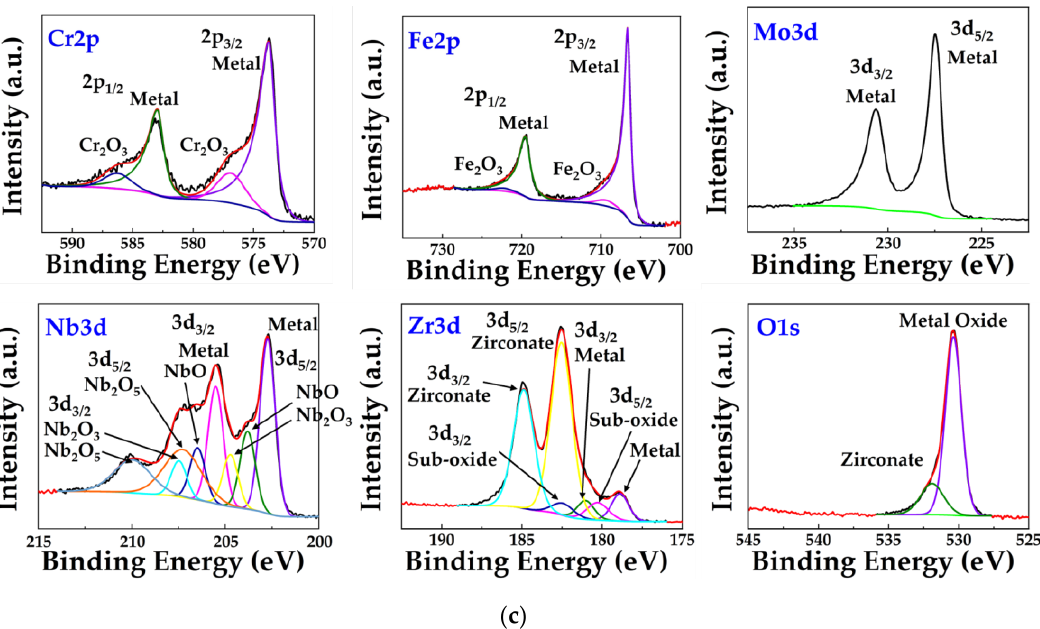
Figure 2. ( a ) X-ray photoelectron (XPS) full spectrum, ( b ) XPS of each element at the thickness of 100 nm below the surface of the (CrFeMoNbZr)O x thin film and ( c ) XPS of each element measured at the surface of the (CrFeMoNbZr)O x thin film.